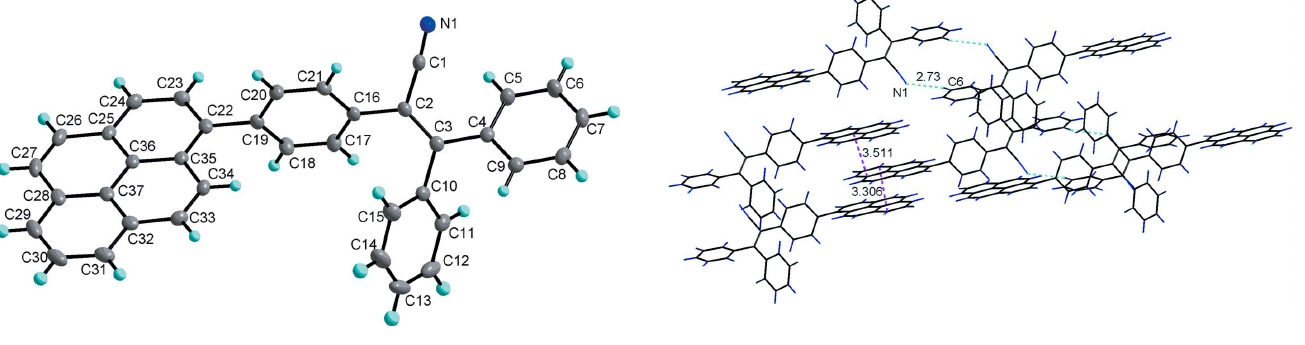
Figure 2 The supramolecular structure of the title compound built up through (cid:2) – (cid:2) and C—H (cid:2)(cid:2)(cid:2) N interactions.